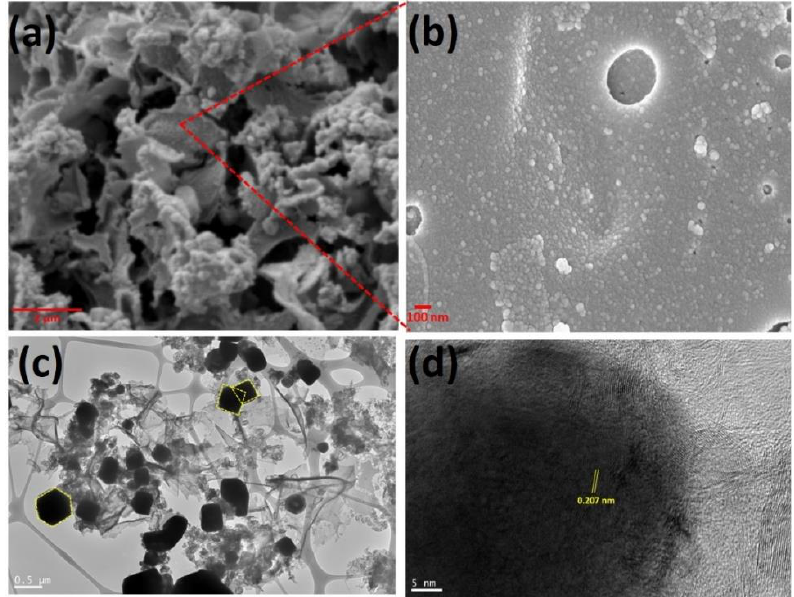
Figure 1. ( a , b ) Low- and high-magnification of FESEM images and ( c , d ) TEM and HR-TEM images of Ni NPs/PCFs.